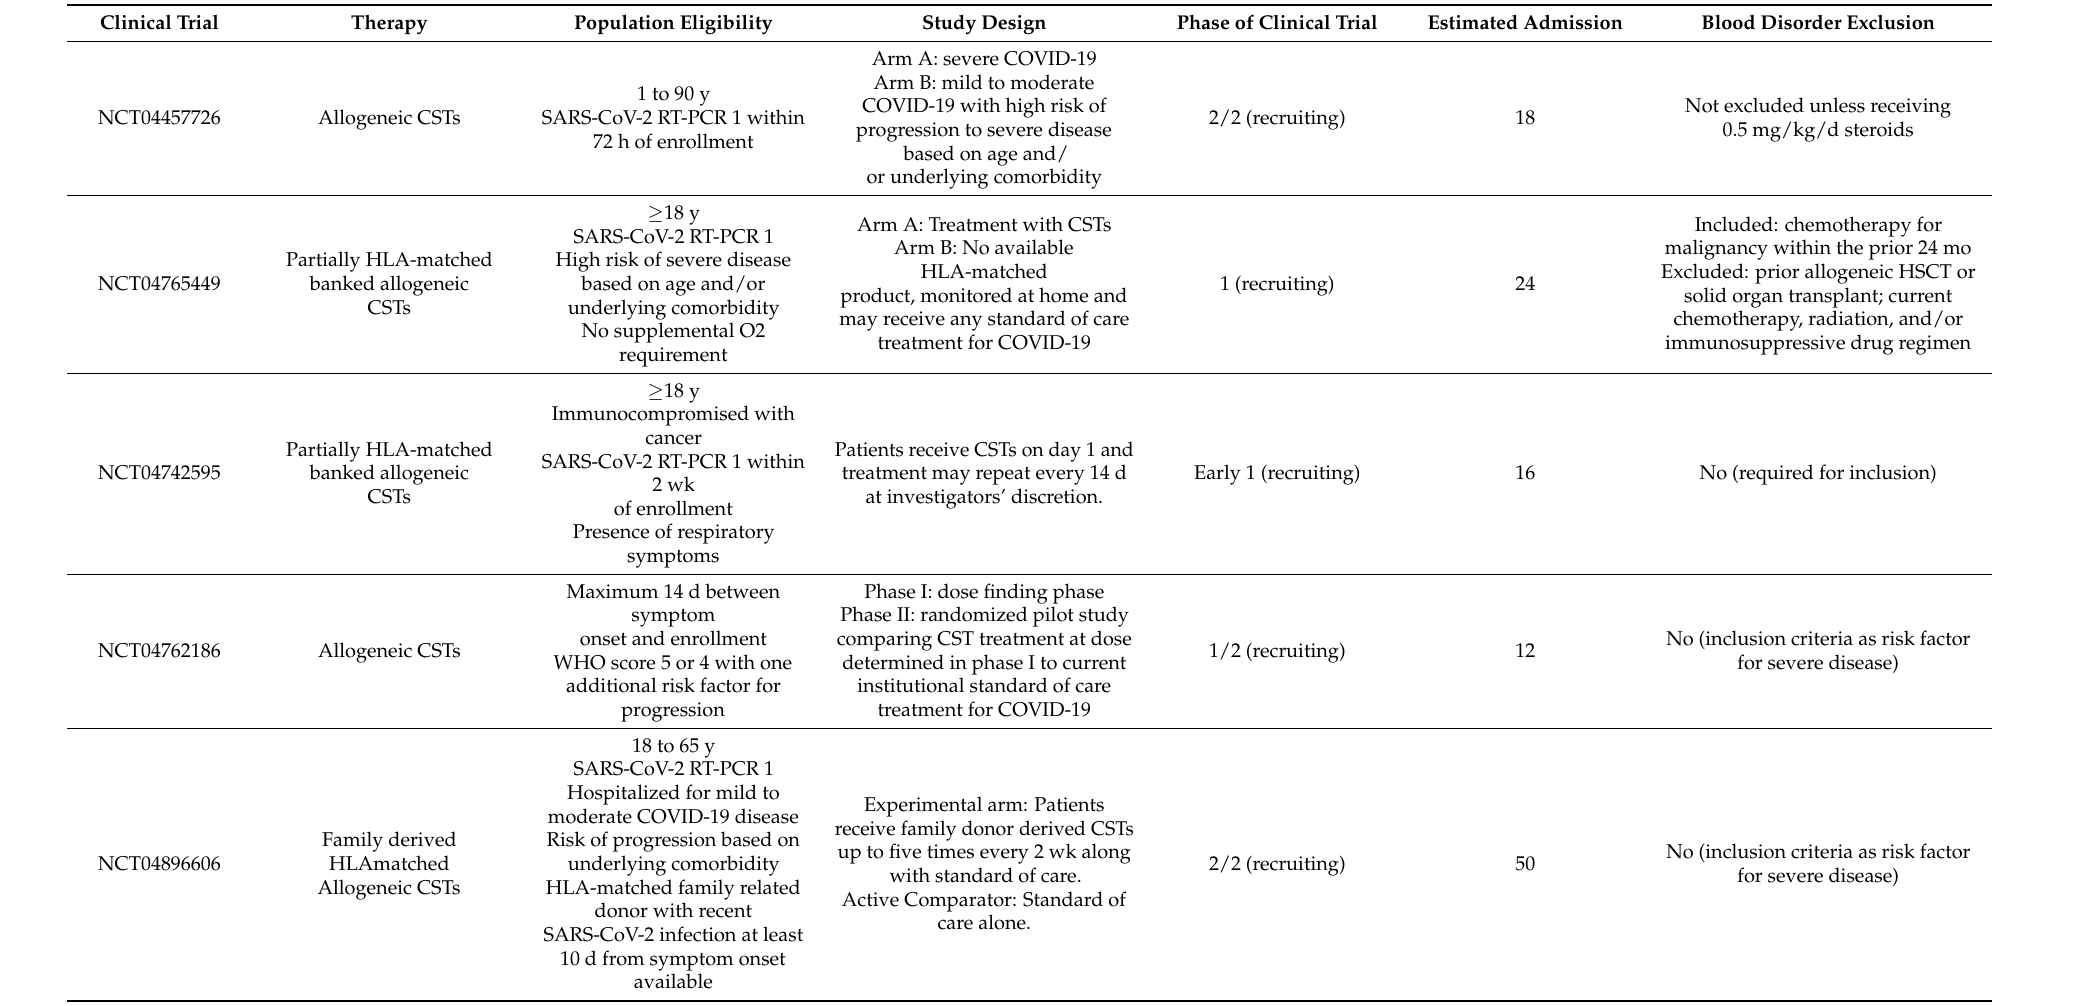
Table 1. SARS-CoV-2-specific T-cell clinical trials for treatment or prevention of severe